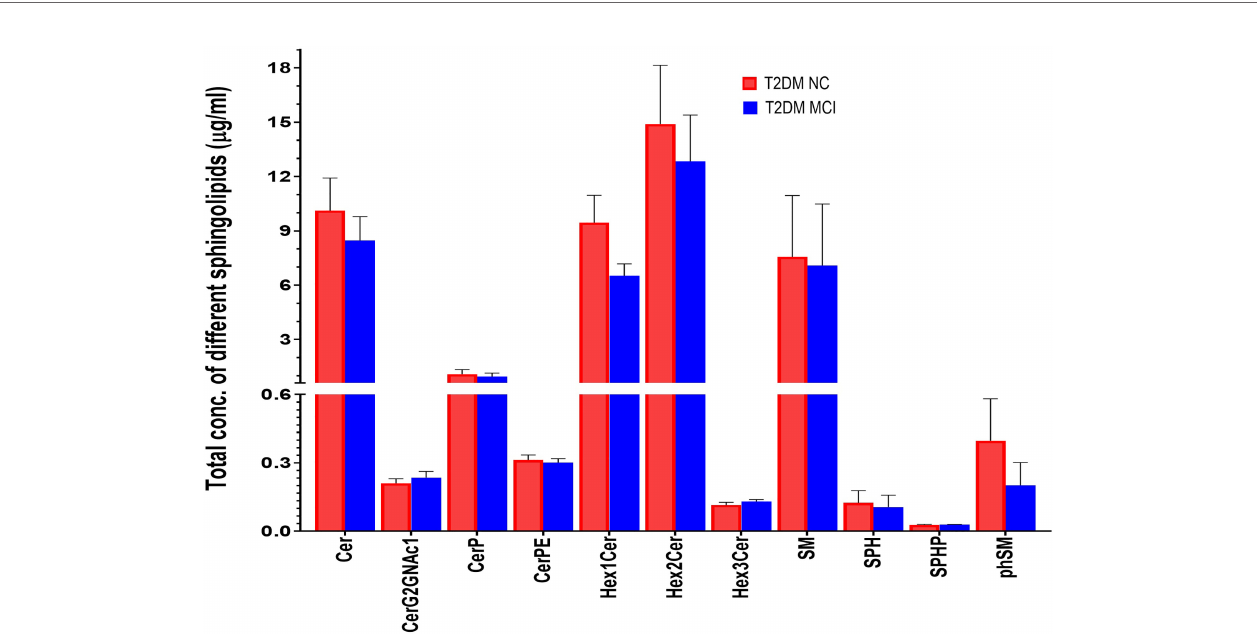
FIGURE 2 | The amount of different sphingolipids in the serum type 2 diabetes mellitus patients with mild cognitive impairment (MCI) versus normal cognition (NC) were evaluated using targeted sphingolipidomic analysis and were presented in Figure 2 . Evaluation of the total amount of different sphingolipids in MCI and NC groups revealed no signi fi cant differences between ceramides (p = 0.47), CerG2GNAc1 (p=0.46), ceramide phosphates (CerP, p=0.67), phosphorylethanolamine ceramides (CerPE, p=0.69), monohexosylceramides (Hex1Cer, p=0.09), dihexosylceramides (Hex2Cer, p=0.62), trihexosyl ceramides (Hex3Cer, p=0.35), sphingomyelins (SM, p=0.92), sphingosine (SP, p=0.8), sphingosine-1-phosphate (SPH, p=0.9) as well as phytosphingomelins (phSM,